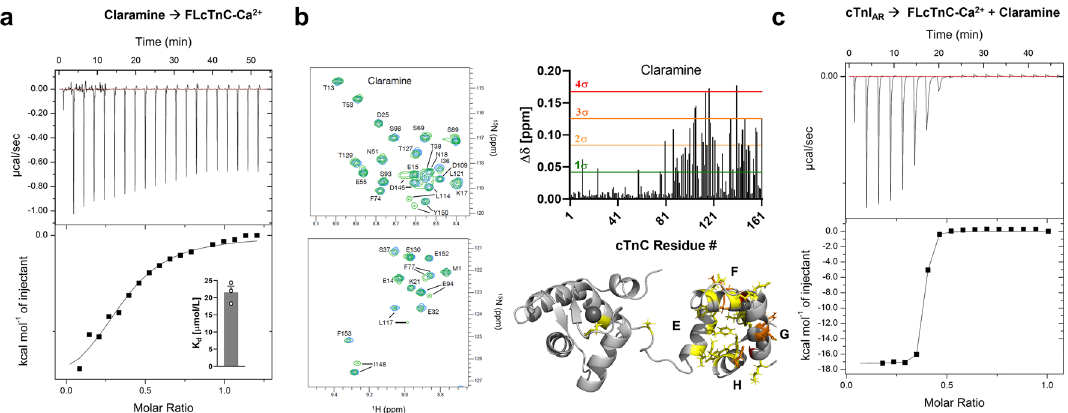
Figure 5. Biophysical characterization of Claramine-cTnC interaction. ( a ) ITC for titration of Claramine into cTnC. Insert: Measured steady-state dissociation constants. ( b ) Left: Part of 2D- 1 H- 15 N HSQC spectrum of cTnC in the absence (blue) and in the presence (purple) of Claramine. Right: Plot of chemical shift perturbations (∆δ) of cTnC after addition of excess Furamidine. Chemical shift perturbations mapped onto cTnC structure. ( c ) ITC titration of unmodified cTnI AR into cTnC in the presence of Claramine (middle). Please note that Claramine had no effect on the cTnC-cTnI AR